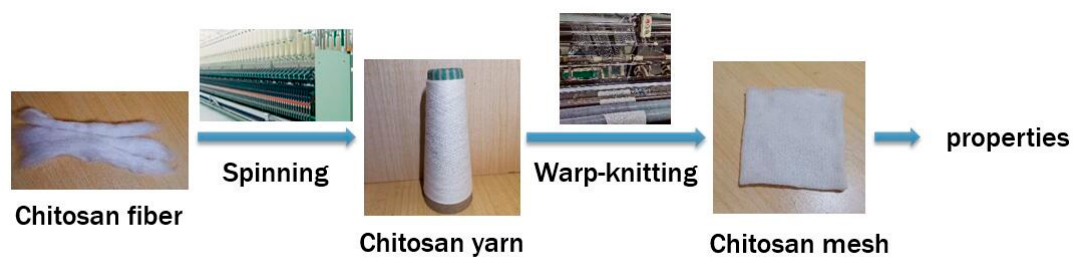
Figure 2. Preparation of chitosan knitted fabrics.